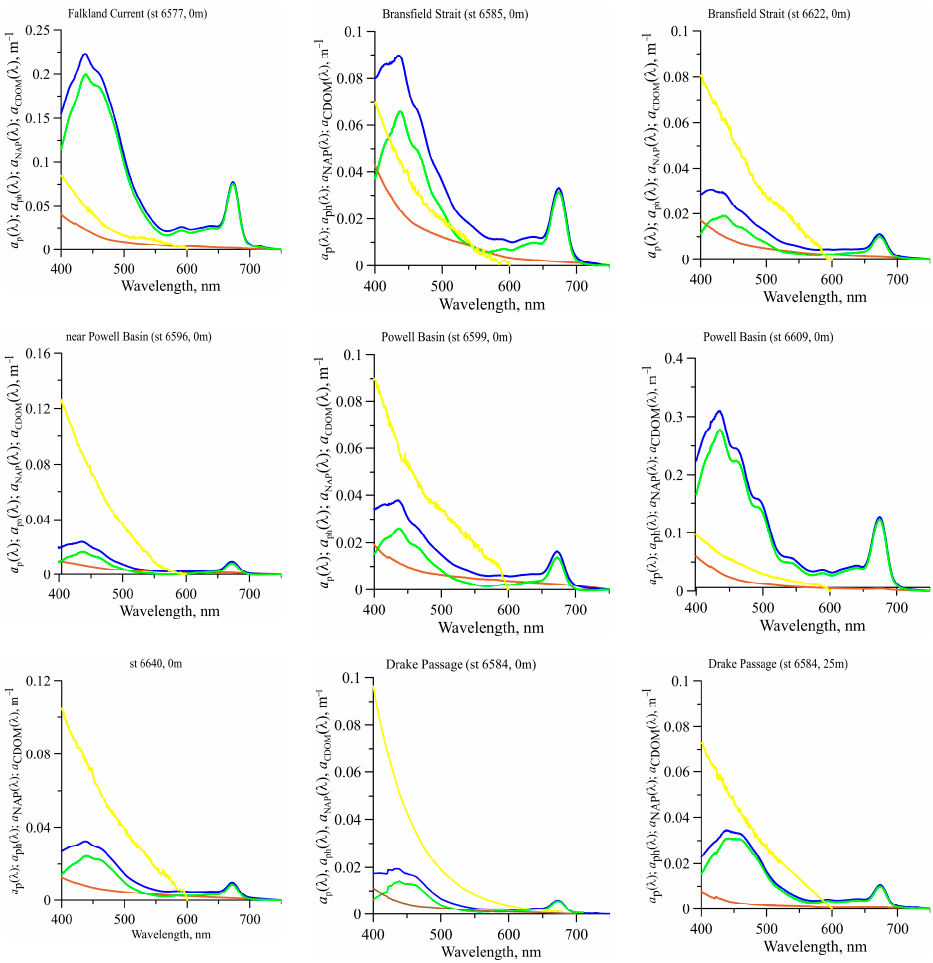
Figure 3. The spectral light absorption coefficient of particles ( a p ( λ ) , blue line), phytoplankton ( a ph ( λ ) , green line), non-algal particles ( a NAP ( λ ) , brown line) and coloured dissolved organic matter ( a CDOM ( λ ) , yellow line) at particular stations corresponding to all regions investigated in the Southern Ocean.